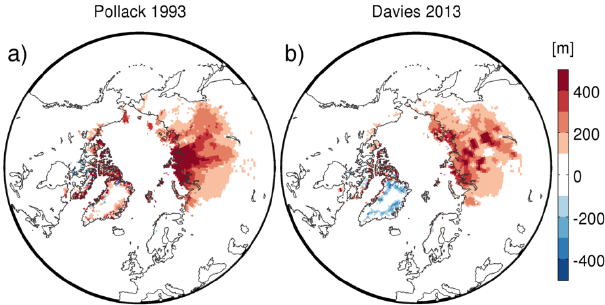
Figure 16. Present-day permafrost disequilibrium for the two model runs with different geothermal heat fluxes: (a) Pollack et al. (1993) and (b) Davies (2013). The equilibrium permafrost thickness is computed numerically as outlined in Appendix B, and the actual permafrost thickness is from the transient model simulations of the last eight glacial cycles.